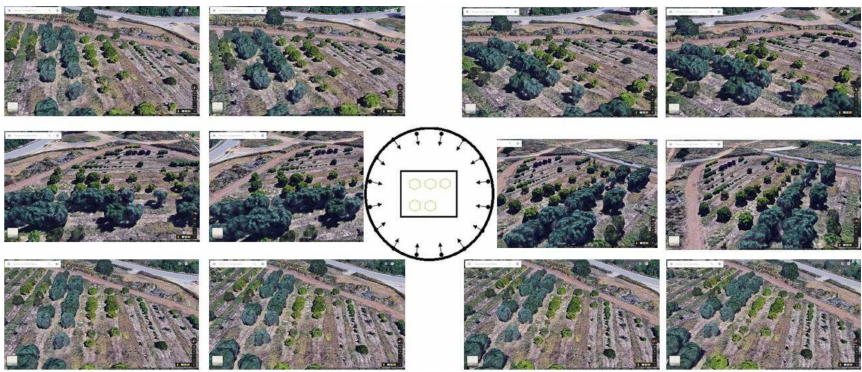
Figure 12. Example of images captured from